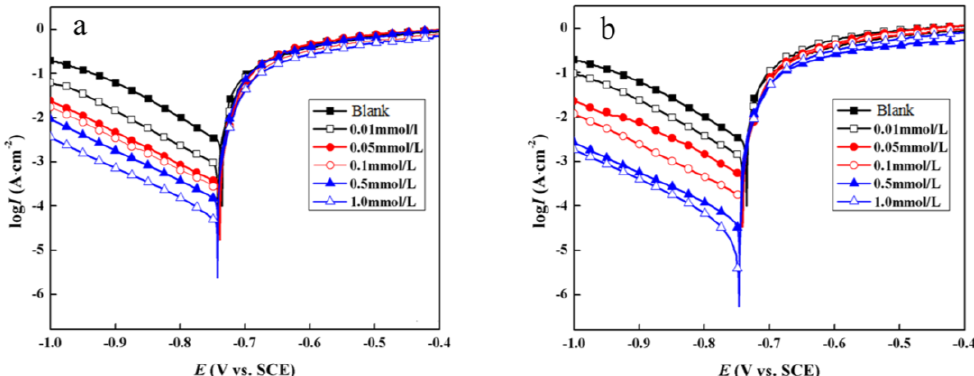
Figure 4. Tafel plots for aluminum alloy in 1 M HCl containing different concentrations of ( a ) DAN and ( b ) DBN. Table 2. Tafel polarization parameters of the corrosion for aluminum alloy in 1 M HCl containing different concentrations of DAN and DBN.